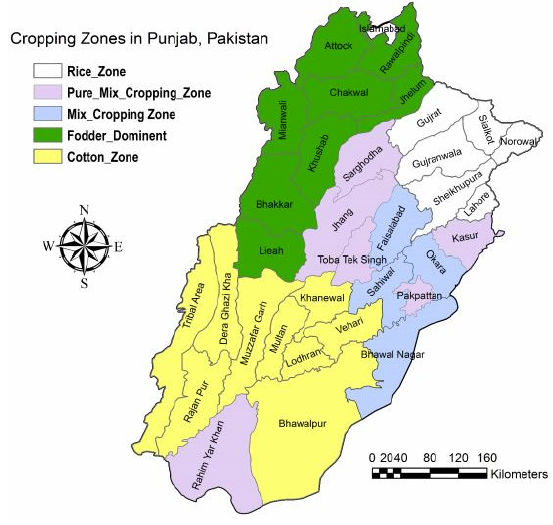
Figure 8. Cropping zones in Punjab, Pakistan [51,52].